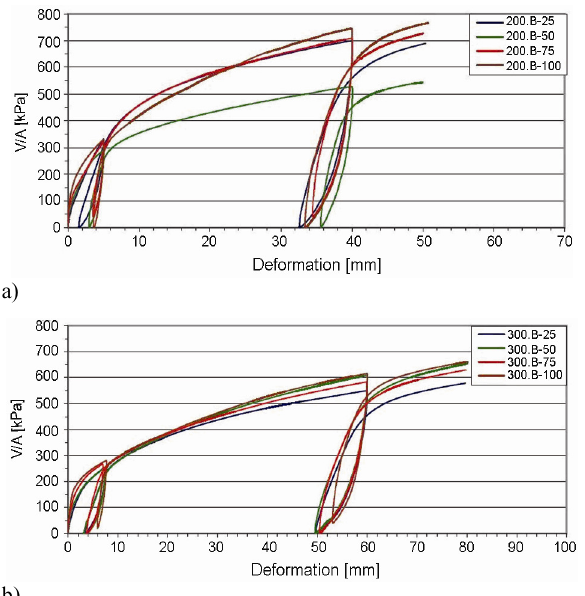
Fig. 11. Failure line in surrounding soil after testing 30 cm